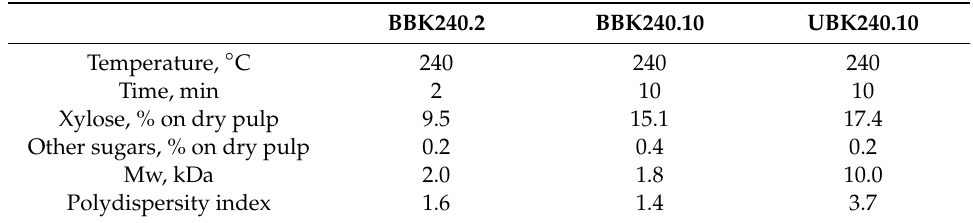
Table 2. Properties of aqueous hydrolysates produced by hot water extraction of bleached (BBK)